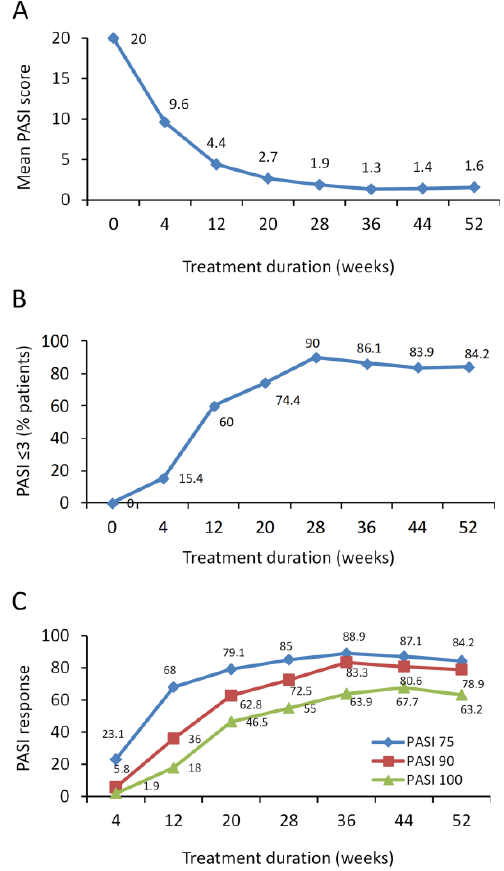
Figure 1. Effect of guselkumab in psoriatic patients on Psoriasis Area and Severity Index (PASI) score and achievement of PASI 75, 90, and 100 response over 1 year. ( A ) PASI is presented as mean values. ( B ) % patients achieving a PASI score ≤ 3 and ( C ) % patients achieving PASI 75, 90, and 100 response.